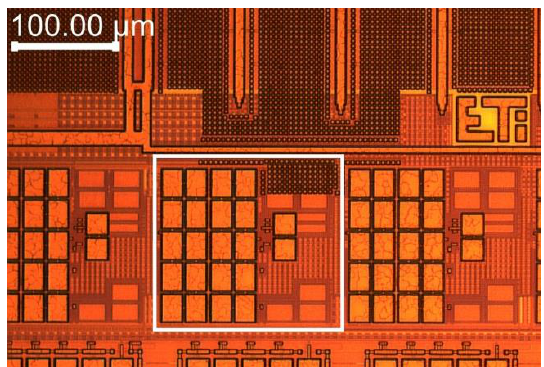
Figure 4. Micro photography of the prototype integrated circuit. A single piece of LTA is marked using a white rectangle.